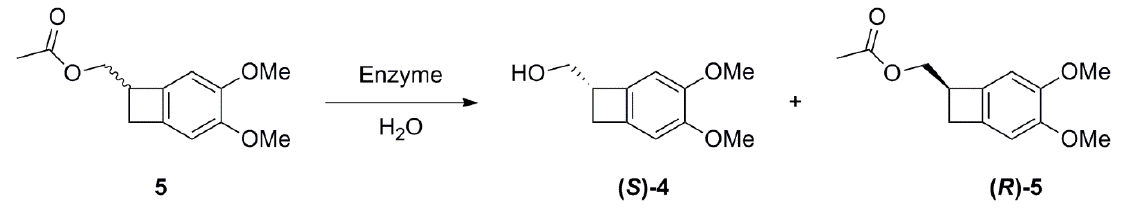
Table 2. Results from screening of enzymes for the hydrolysis of racemic